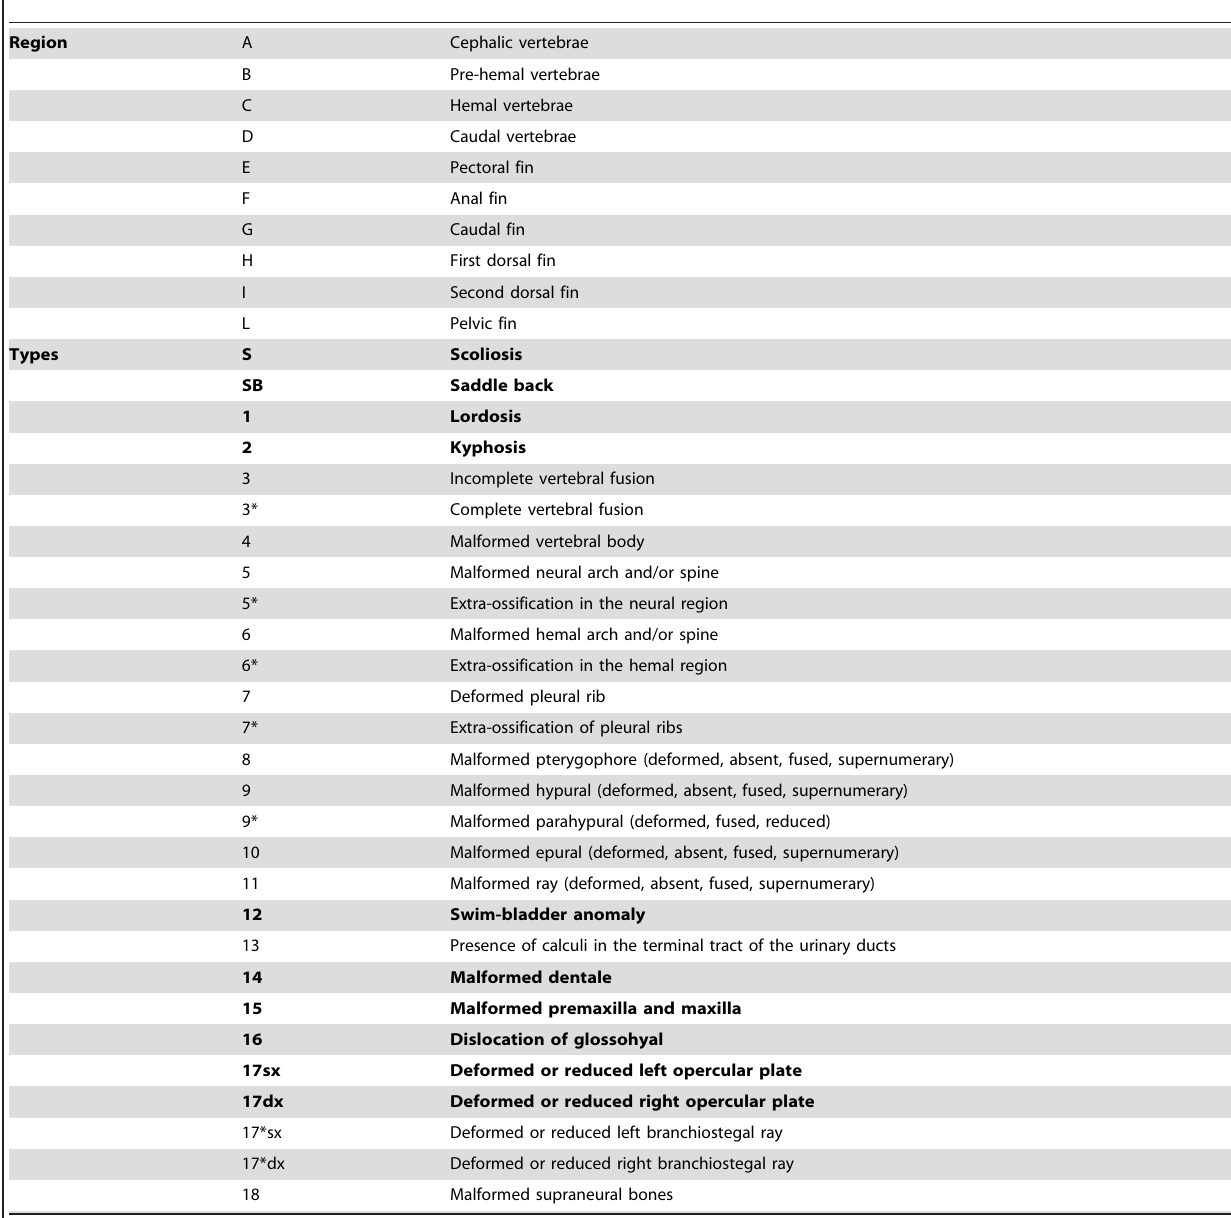
Table 3. List of anomalies considered. Bold font indicates commercially severe anomalies.